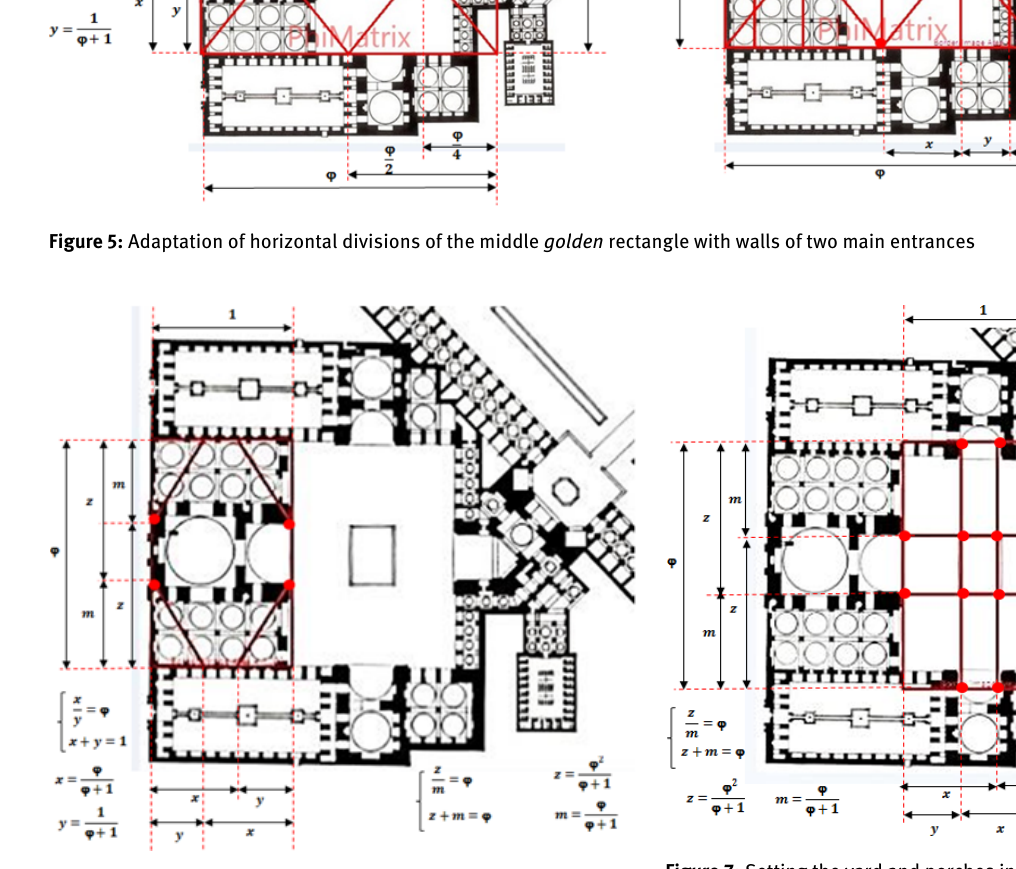
of this entrance are located in golden distances with yard space (Figure 6).